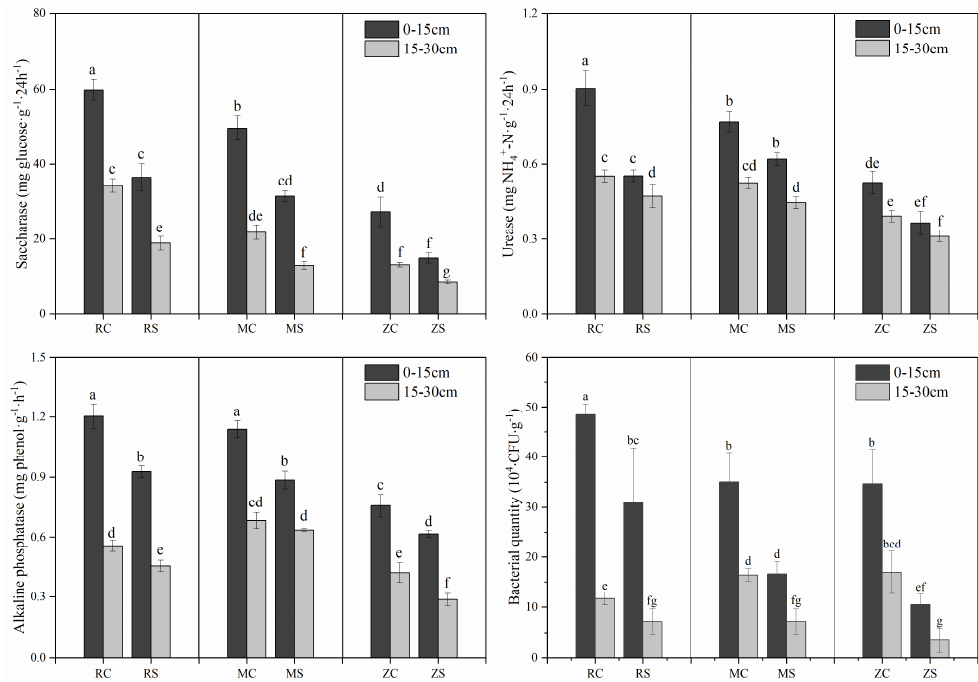
Figure 4. Changes in soil enzyme (saccharase, urease, and alkaline phosphatase) activities and bacterial quantity in the control and subsidence areas of three coal mines. Different lowercase letters indicate significant differences at 0.05 ( p < 0.05) levels.